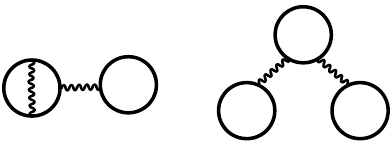
Figure 6 . Reducible diagrams contributing to the three-loop